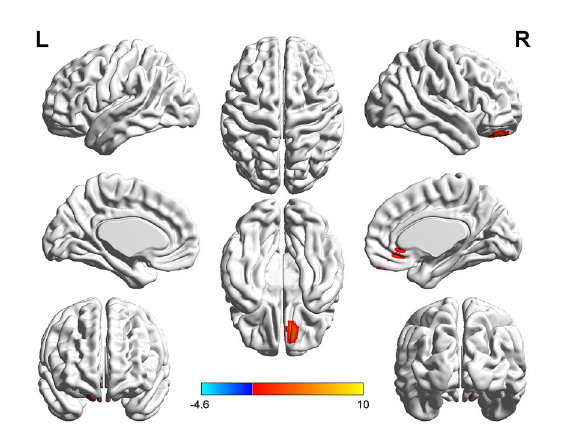
FIGURE1 T -value map of differential results of mALFF between left auditory neuroma and healthy controls. Compared with healthy controls, the value of mALFF in the right caudate nucleus of patients with left acoustic neuroma was increased, and there was no significant decrease in the brain regions. The statistical threshold was voxel-wise p < 0.001 with cluster-wise FWE corrected p < 0.05 (122 voxels).